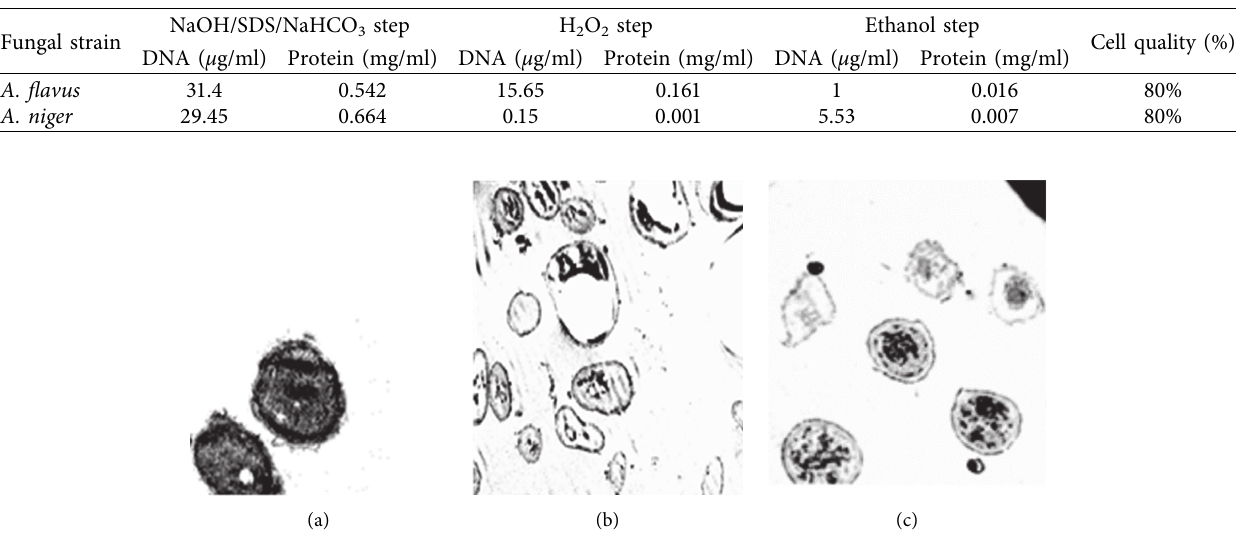
Figure 1: Transmission electron microscope images indicating evacuation and morphological changes in appearance of formed A. flavus and A. niger ghost cells (magnification at 2000X). (a) A. flavus control cells; (b) A. flavus ghost and dead cells; and (c) A. niger ghost and dead